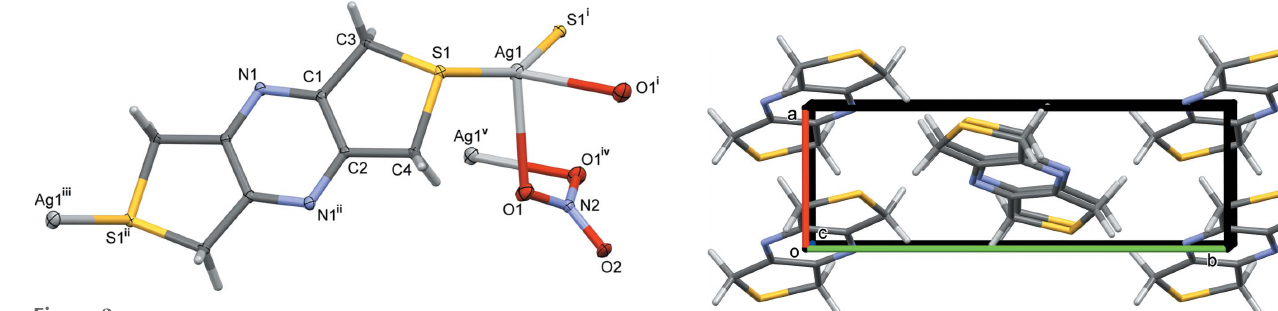
Figure 3 The asymmetric unit of complex I , with atom labelling [symmetry codes: (i) (cid:4) x + 1 , y , (cid:4) z + 3 ; (ii) (cid:4) x + 1, (cid:4) y , (cid:4) z + 2; (iii) (cid:4) x + 1, (cid:4) y + 1, (cid:4) z + 2; 2 2 (iv) (cid:4) x + 3 , y , (cid:4) z + 3 ; (v) x + 1, y , z ]. Displacement ellipsoids are drawn at 2 2 the 30% probability level.